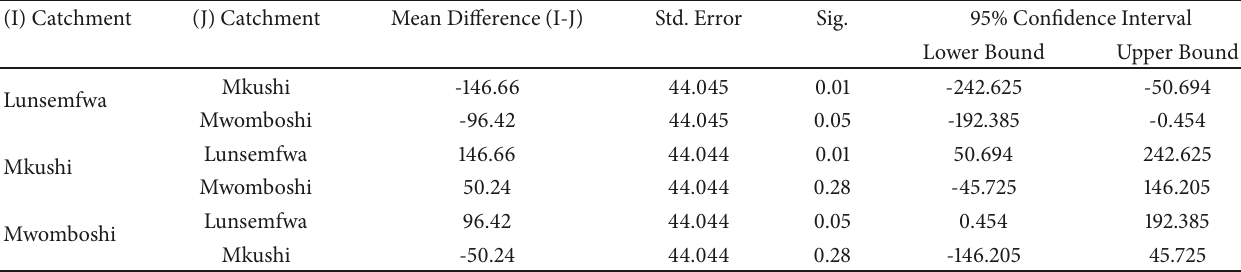
Table 6: Multiple Comparisons of wheat Net irrigation water [mm/ha] 2013 to 2017 LSD.